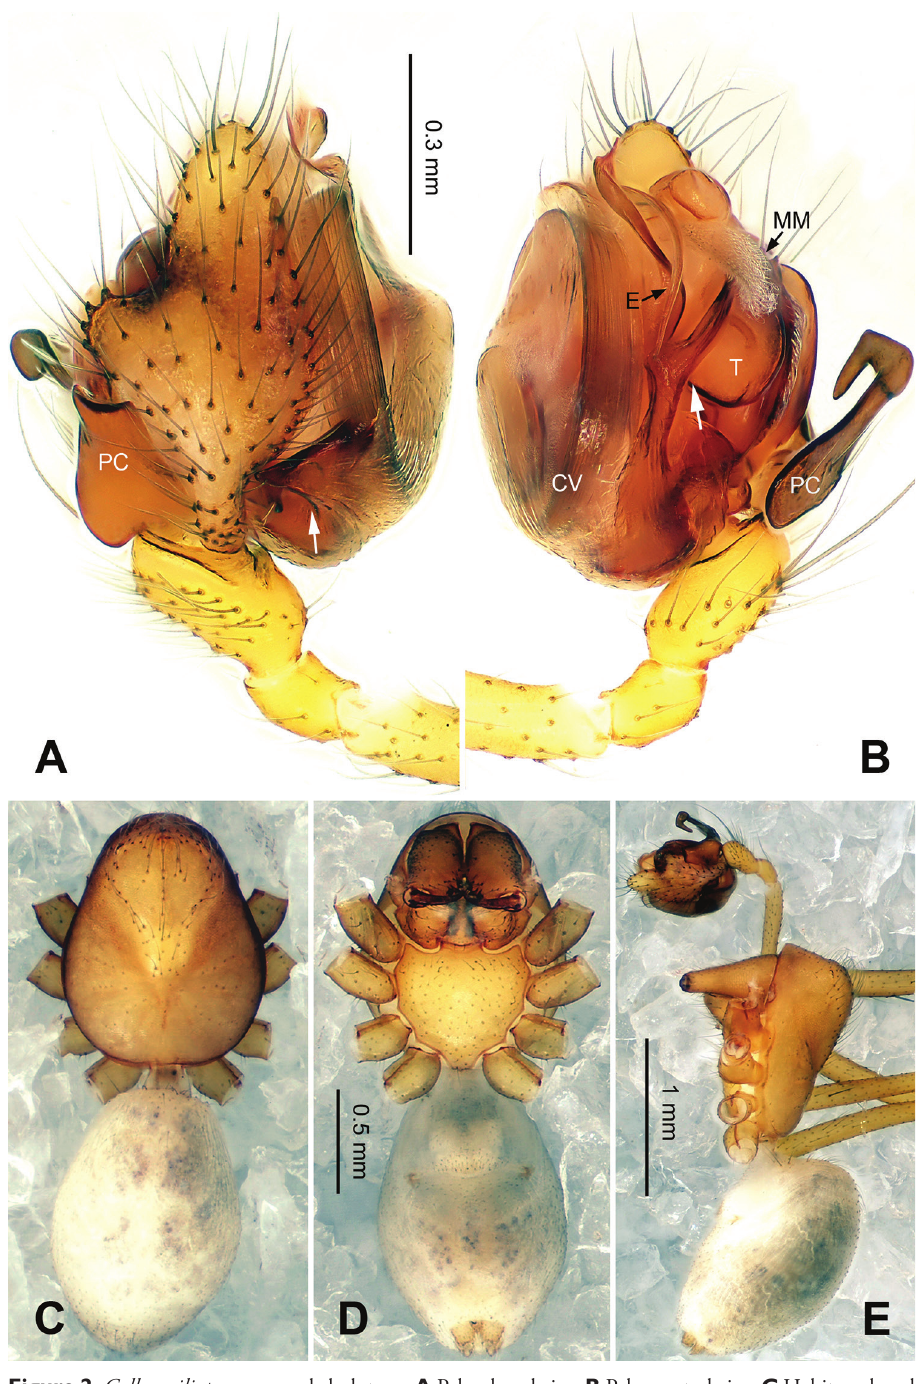
Figure 2. Callosa ciliata sp. n., male holotype. A Palp, dorsal view B Palp, ventral view C Habitus, dorsal view D Habitus, ventral view E Habitus, lateral view. Scale bars: B as A ; C as D